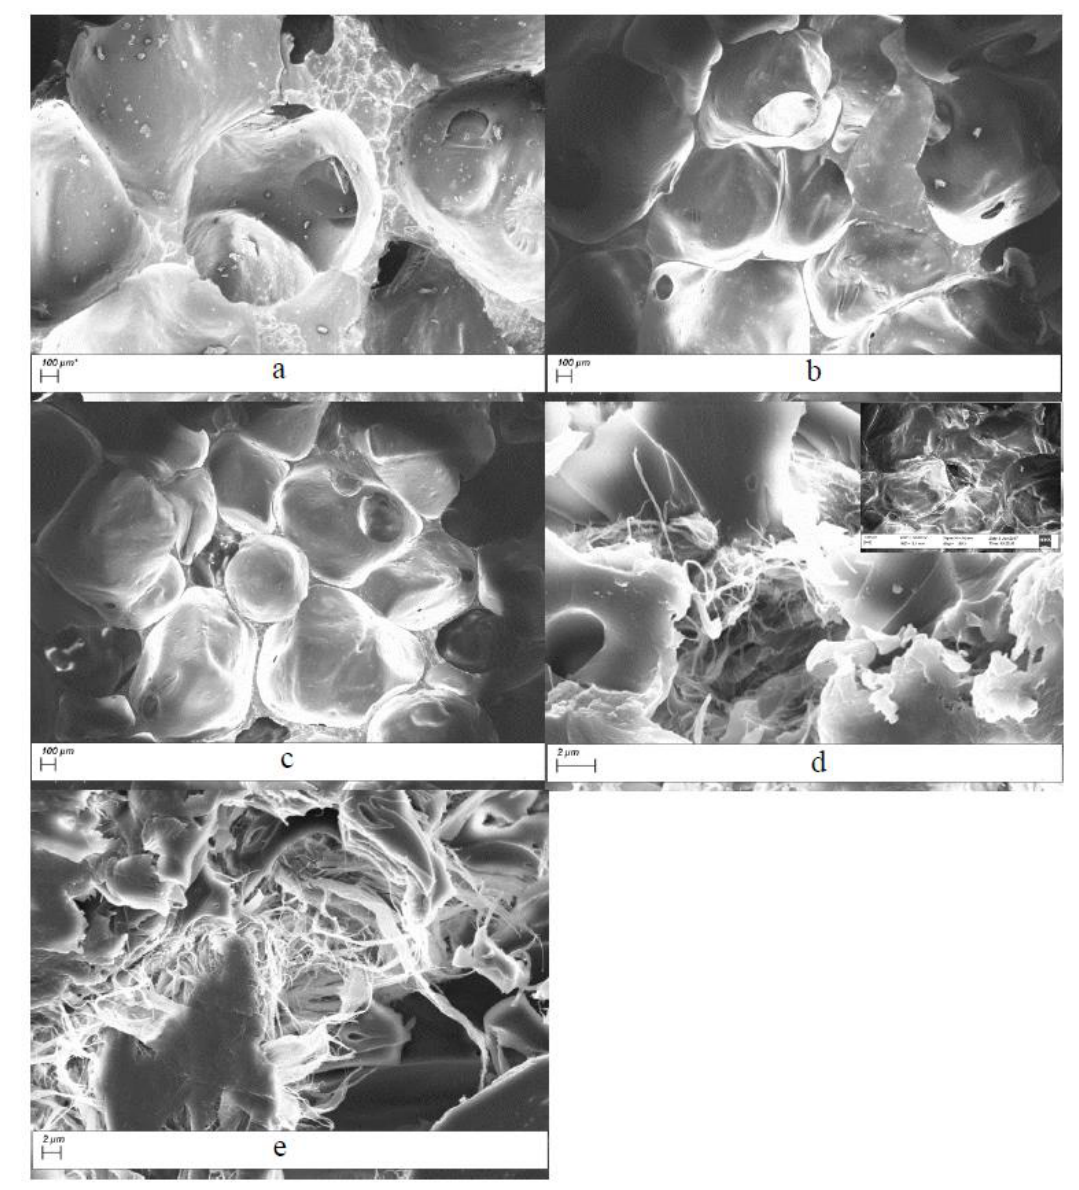
Figure 1. SEM images of ( a ) PUF control and CNF-PUF with ( b ) 10%, ( c ) 20%, ( d ) 30%, ( e ) 40% CNF replacement ratios.